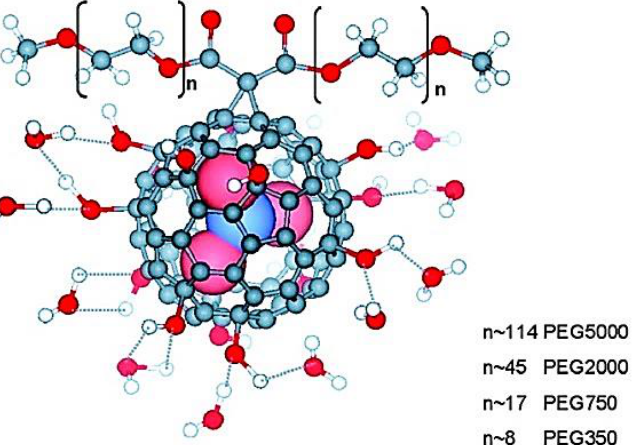
Figure 6. Depiction of the chemical structure of a Gd 3 N@C 80 [DiPEG(OH) x ] endohedral fullerene particle. Gd 3 N@C 80 [DiPEG(OH) x ] = Trimetallic nitride/fullerene/dipoly(ethylene glycol) hydroxide [109]. Reproduced with permission from ACS.